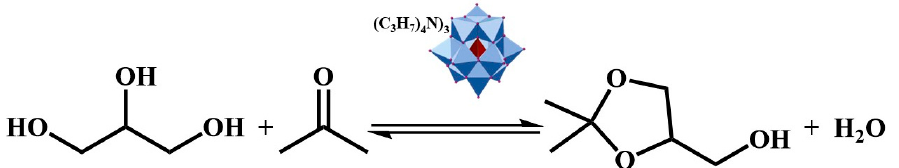
Figure 24. Solketal yield achieved in glycerol condensation with acetone over H 3 PW 12 O 40,